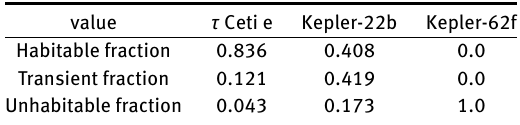
Table 2. Conditional probability integrated over all planetary param- eters studied using the Monte Carlo